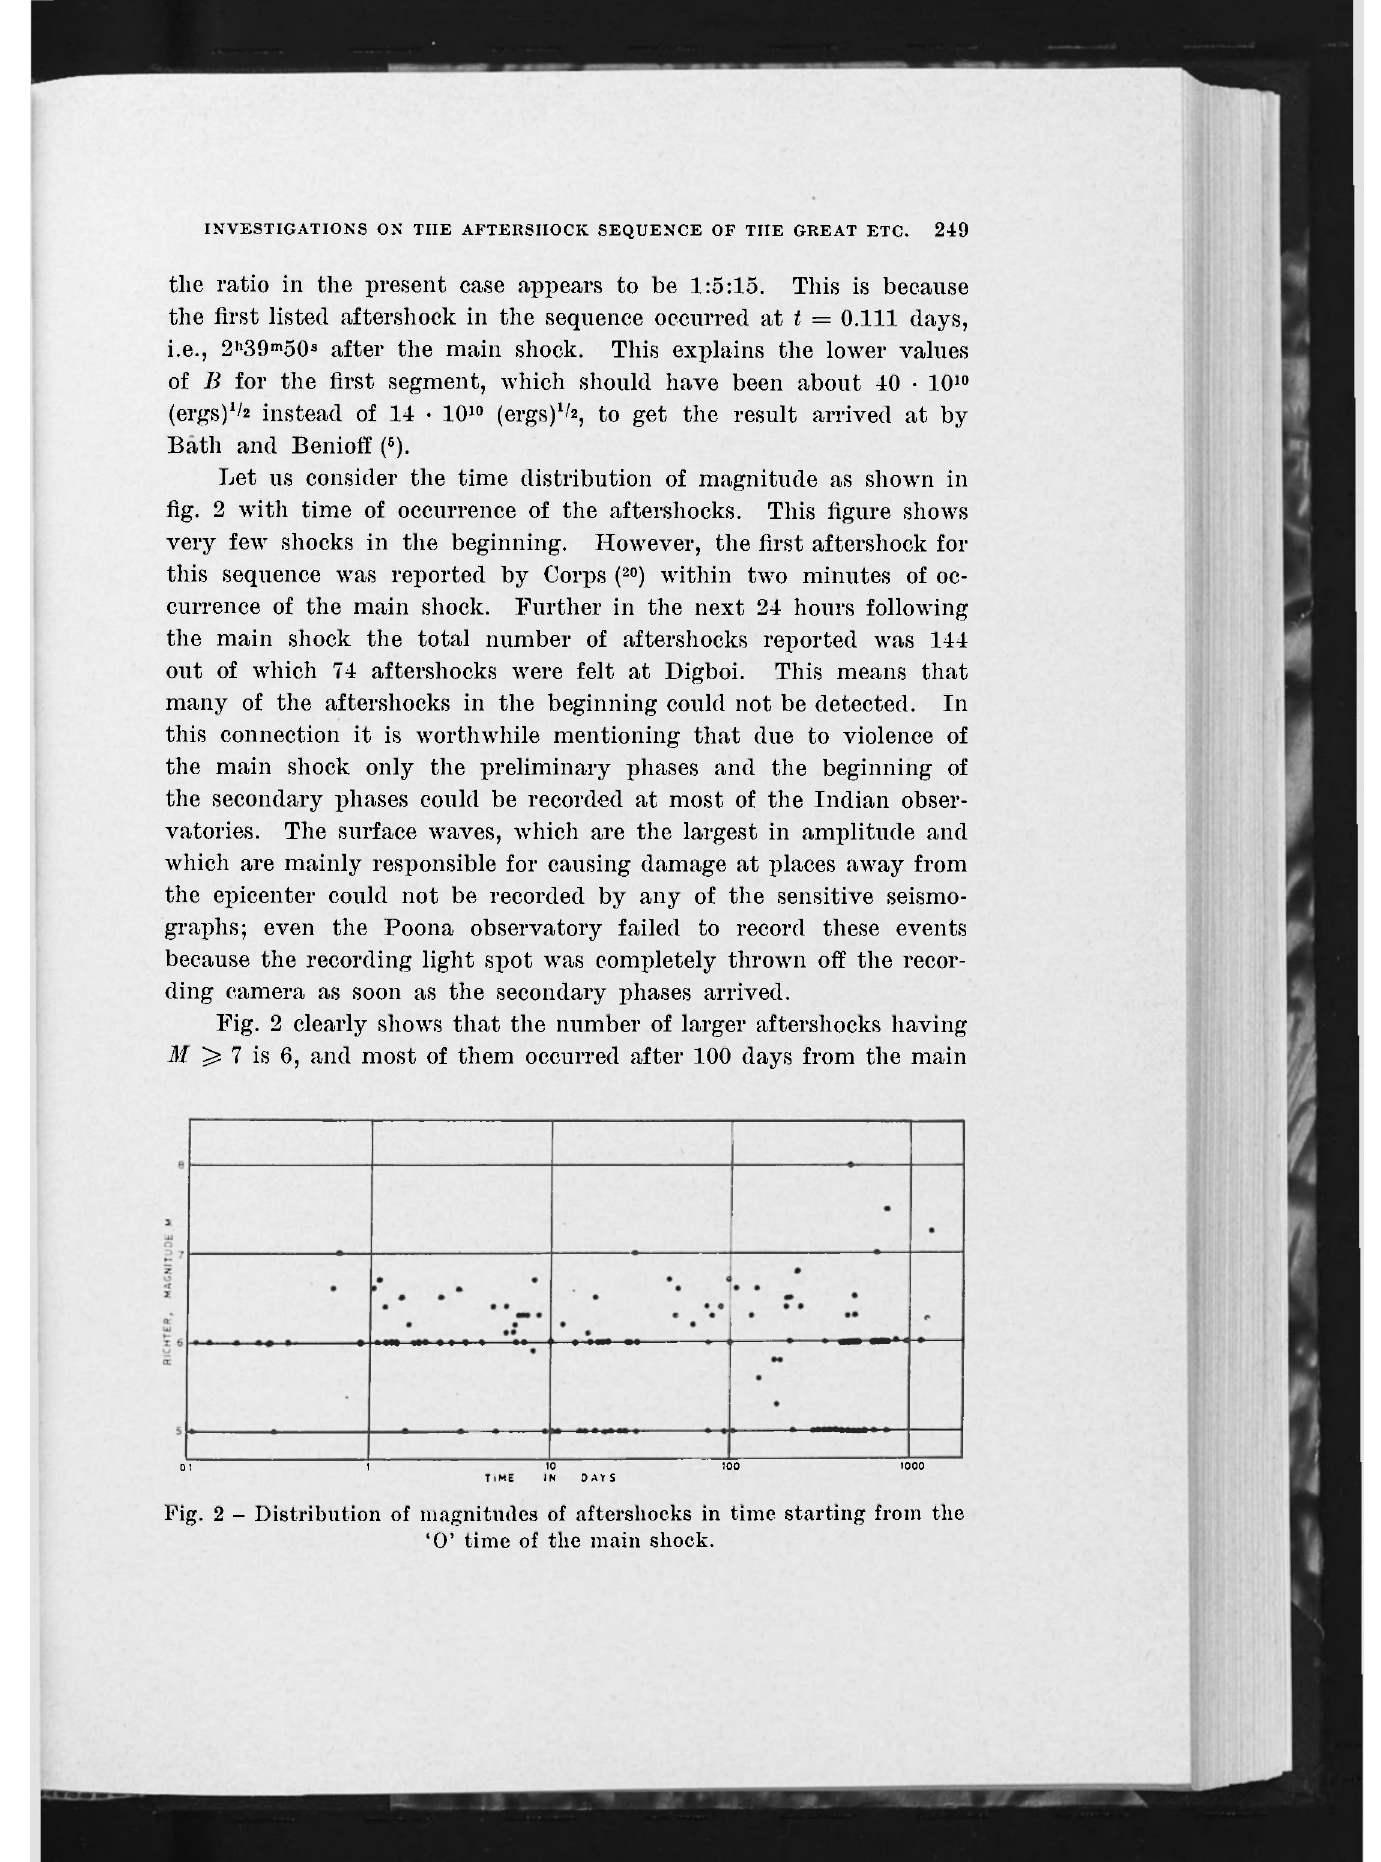
Fig. 2 - Distribution of magnitudes of aftershocks in time starting from the 'O' time of the main